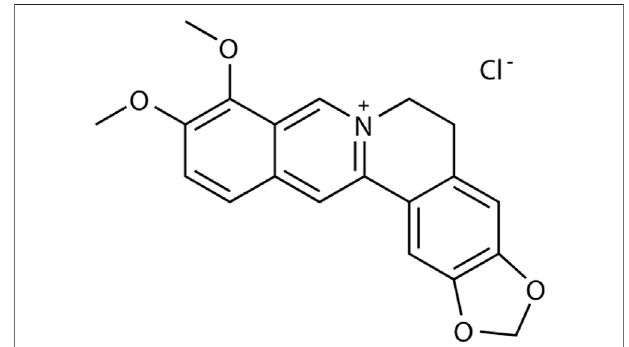
FIGURE 1 | Structure of